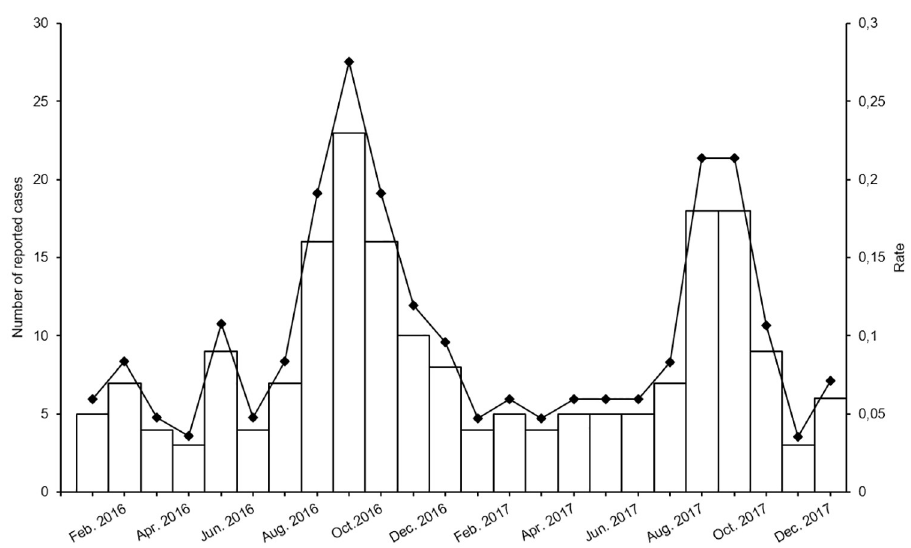
Fig 1. Number and crude incidence rate of reported cases by month of notification, 2016–2017. Crude incidence rate per 100,000 population.